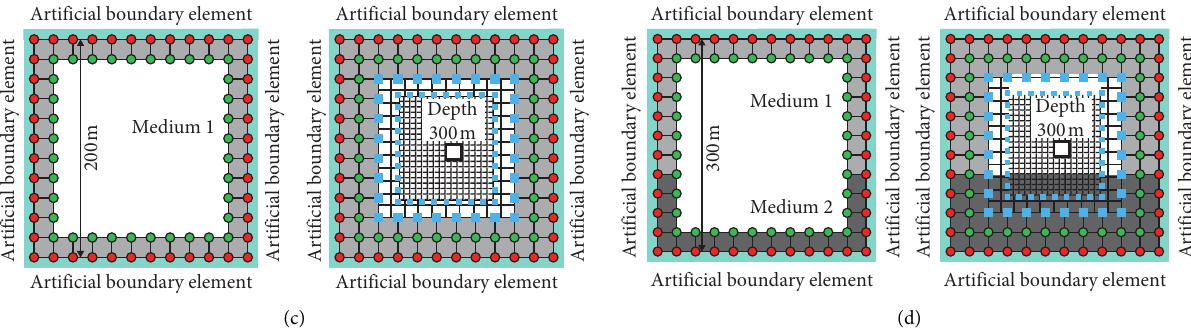
Figure 19: Four example models of complex layered fields: (a) Example 4.2.1, (b) Example 4.2.2, (c) Example 4.2.3, and (d) Example 4.2.4.